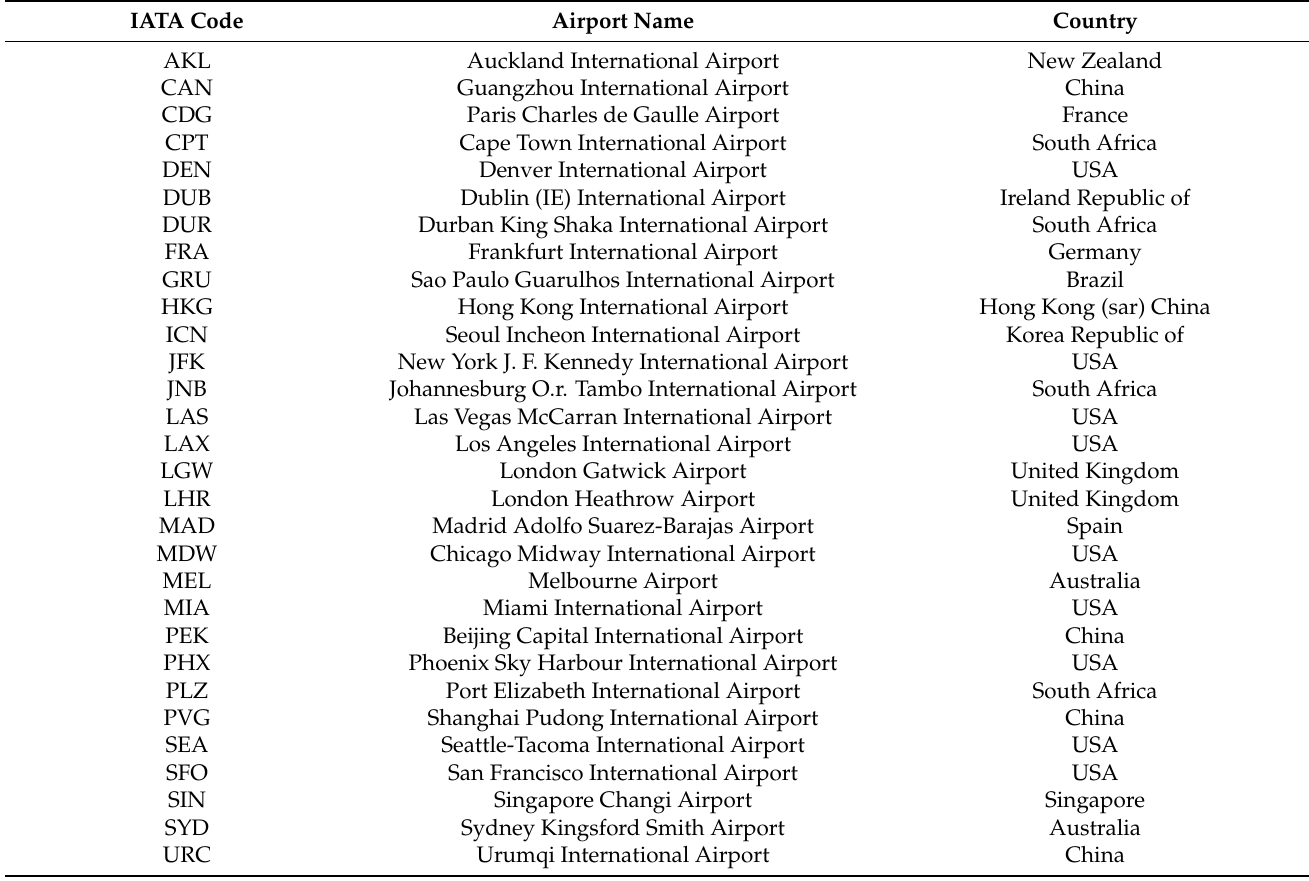
Table A1. Airport